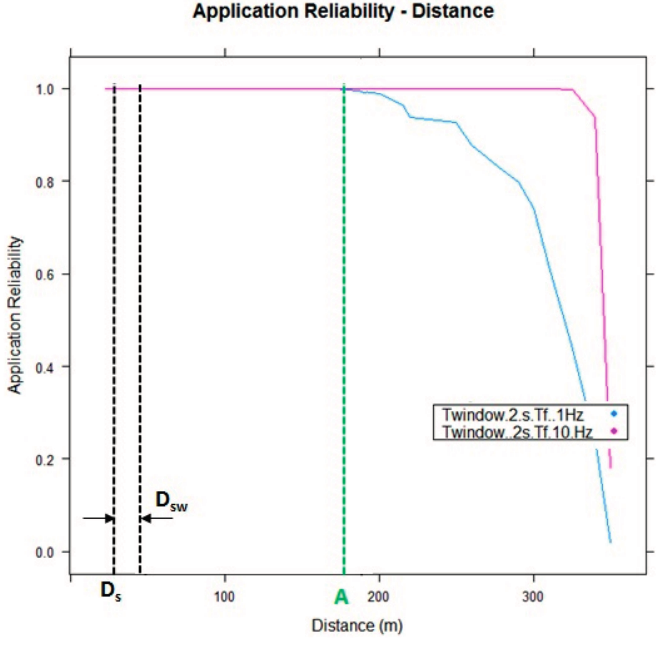
Figure 15. V-Alert application